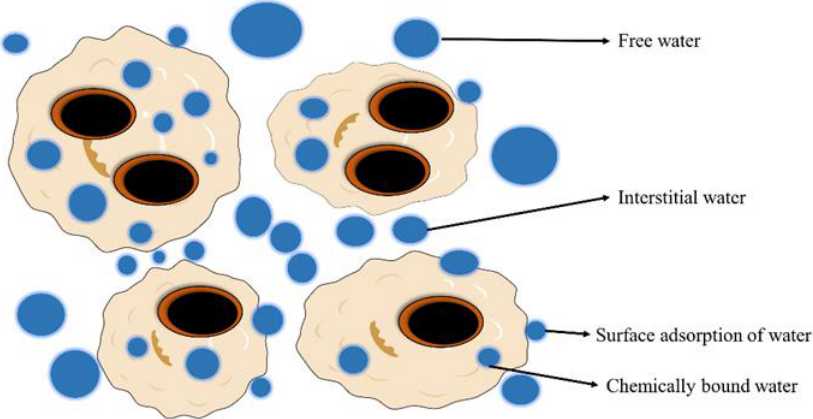
Figure 3. Form of water present in sludge.